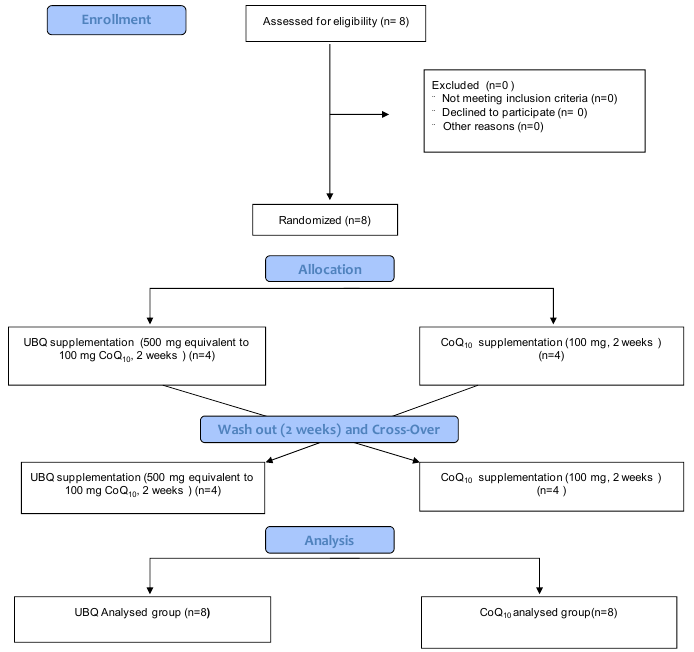
Figure 1. CONSORT flowchart. A total number of 8 patients were enrolled. Volunteers were randomized in 2 groups (CoQ 10 , crystallized CoQ 10 and UBQ, Ubiqsome) according to a crossover design. For for LDL extraction plasma was subsequently pooled into 2 groups, each one containing plasma from 4 patients.